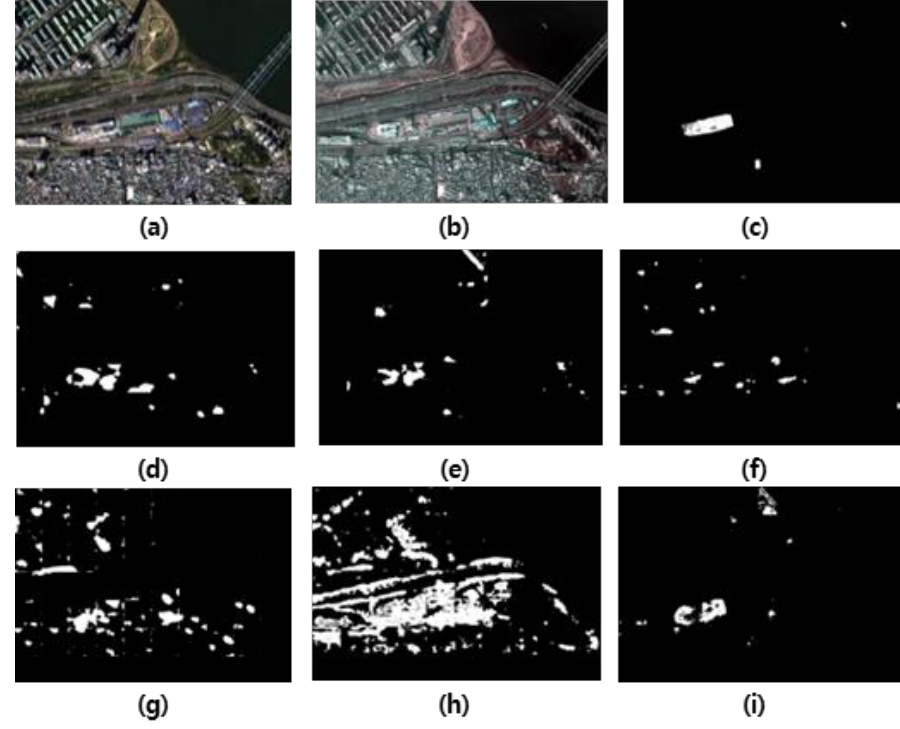
Figure 18. Changed detection maps of the proposed and conventional algorithms for “Test area 4”: ( a ) Image P; ( b ) Image C; ( c ) Ground truth; ( d ) DI + UNet; ( e ) DI + ATTUNet; ( f ) JF + UNet; ( g ) JF + ATTUNet; ( h ) Modified-UNet++; ( i ) Proposed bilateral U-Net.